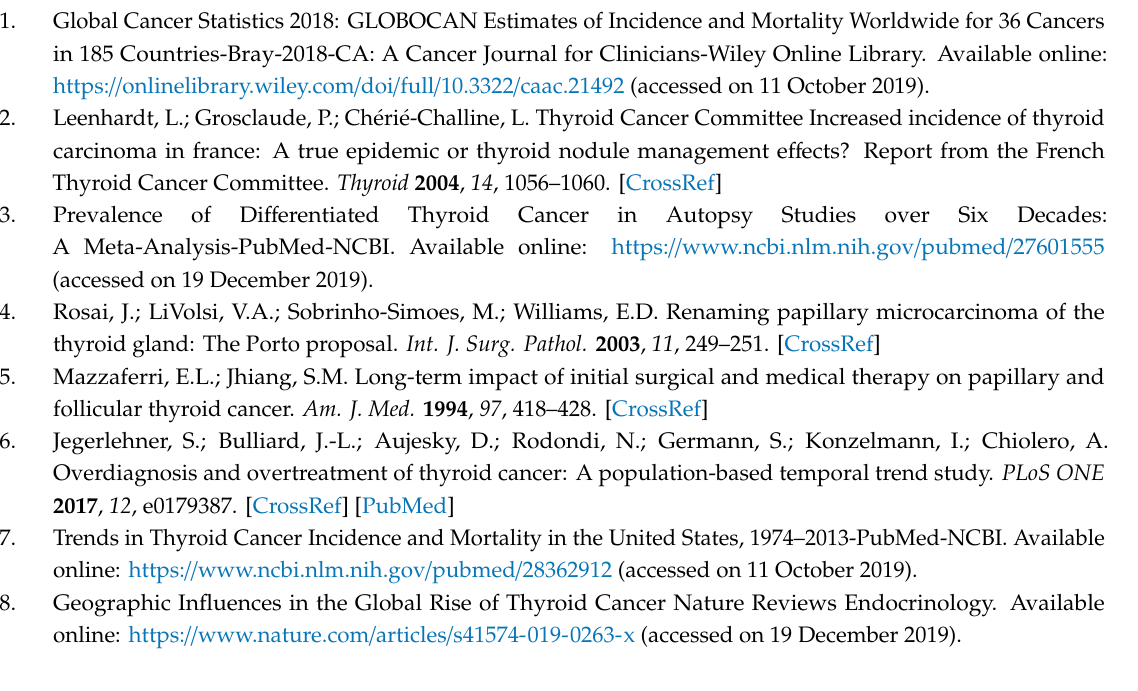
Table S1: Characteristics of the study group, Table S2: Relationship between rs966423 and histoclinic factors, response to therapy, follow-up, and overall mortality, Table S3: Relationship between rs966423 and ATA low-risk, Table S4: Relationship between rs966423 and ATA intermediate-risk, Table S5: Relationship between rs966423 and ATA high-risk, Table S6: Relationship between rs966423 and histoclinic factors, response to therapy, follow-up, and overall mortality for patients with longer